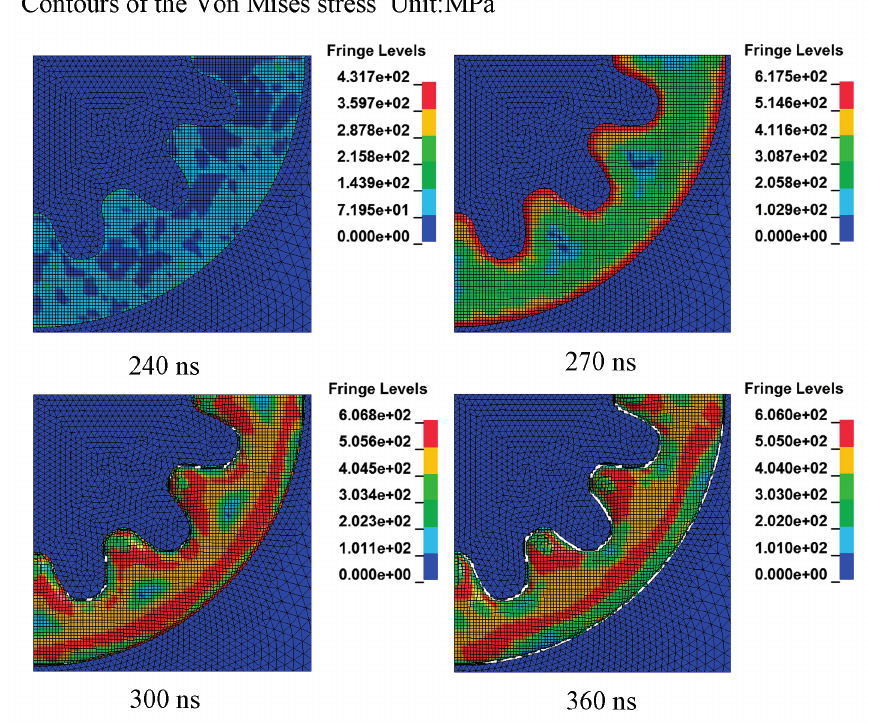
Figure 12. Typical stages of material deformation in laser shock punching